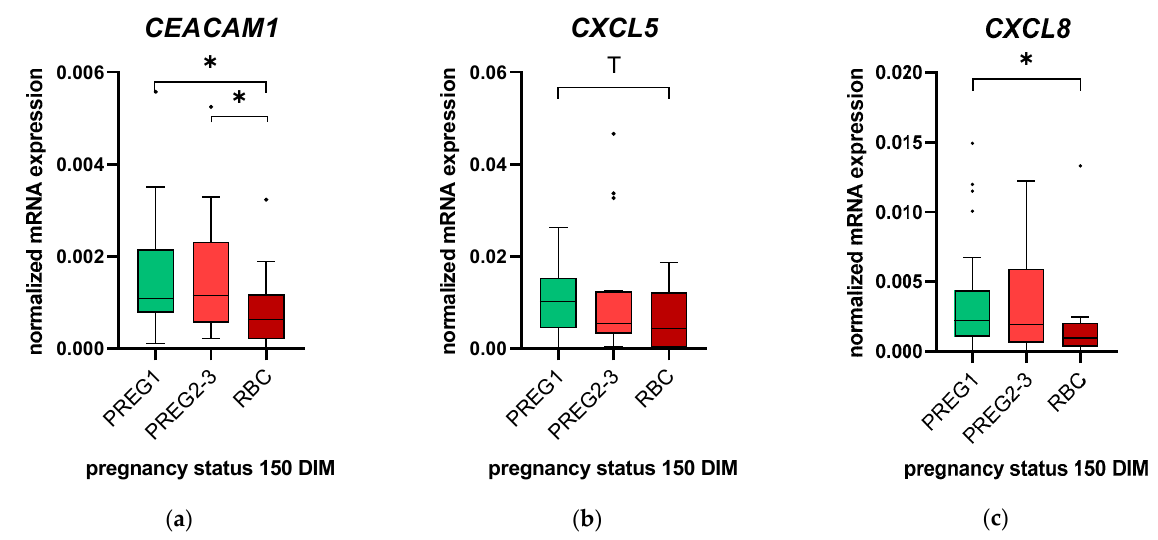
Figure 2. Normalized CEACAM1 ( a ), CXCL5 ( b ) and CXCL8 ( c ) mRNA expression in endometrial cytobrush samples collected from animals at the time of artificial insemination. Animals were retrospectively grouped by animals that conceived after the first (PREG1, n = 32) or second or third AI (PREG2-3, n = 19) or animals with more than three unsuccessful AIs, i.e., repeat breeder cows (RBC, n = 13), until 150 days in milk (DIM). Values are represented as box-and-whisker plots with median values and 50% of the data within the boxes. Whiskers include all data points within 1.5 times the interquartile range (IQR). All outliers ( ≥ 1.5 times IQR) were included in the statistical analyses. Significant differences with p ≤ 0.05 between groups are indicated with an asterisk (*), and a trend towards statistical significance ( p = 0.051–0.1) is marked with a “T”. Animals 2021 , 11 , x